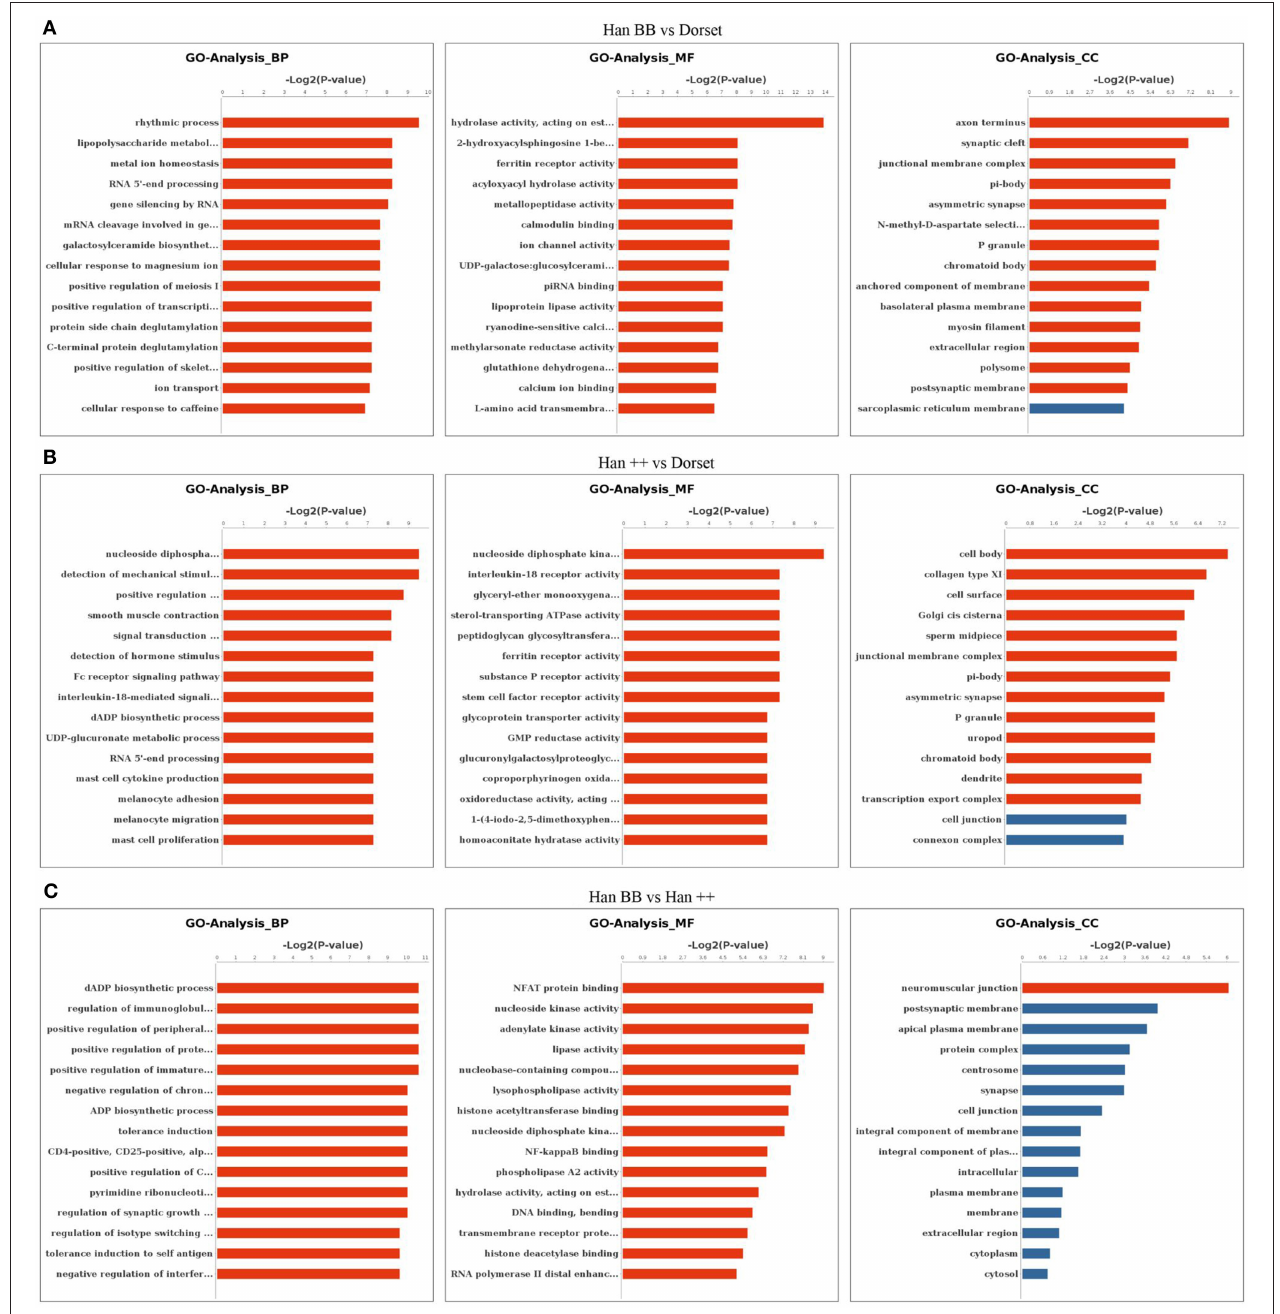
FIGURE 1 | Gene Ontology analysis of the methylated differentially expressed genes in the different sheep groups. (A) Han BB vs. Dorset; (B) Han ++ vs. Dorset; (C) Han BB vs. Han ++ . Han BB, Small Tail Han ewes with the genotype BB (HanBB) and genotype ++ (Han ++ ); Dorset, Dorset sheep. BP, Biological process; CC, cell component; MF, molecular